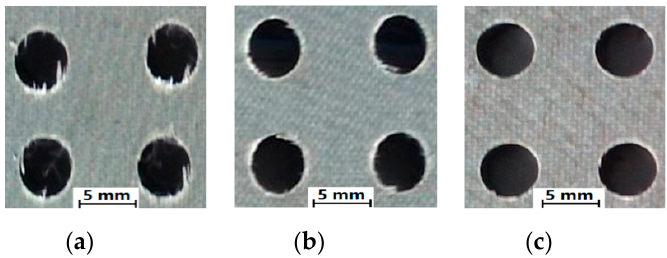
Figure 4. The appearance of the hole exit using three types of cushion plates: ( a ) pine; ( b ) Al5051; ( c ) ABS plastic.